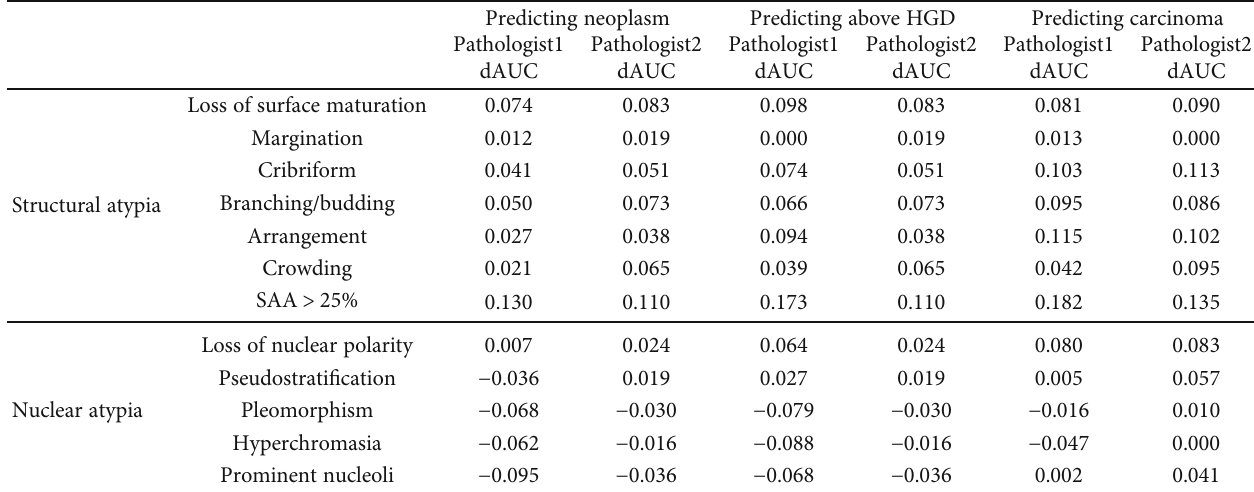
Figure 4: Multivariate analysis of pathologic factors for predicting fi nal diagnosis. Data for the di ff erence in area under the curve are summarized in Table 5. Table 5: Multivariate analysis of pathologic factors for predicting fi nal